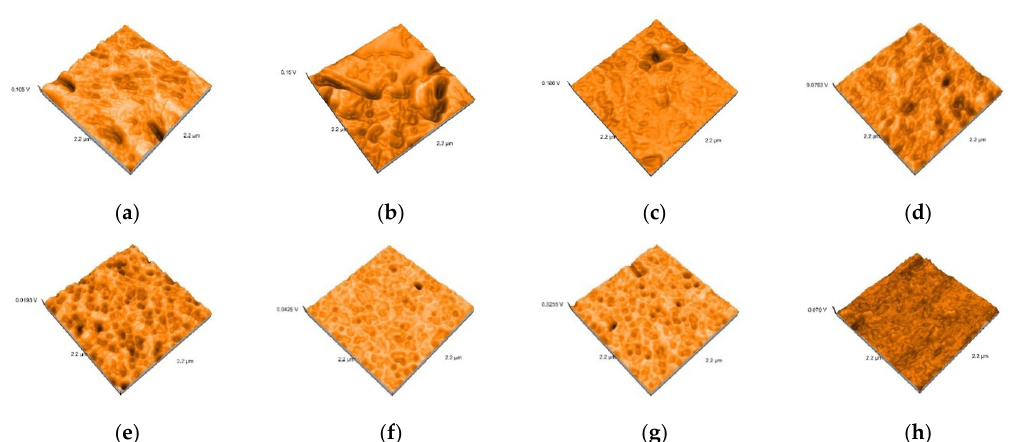
Figure 6. 3D images of Shofu HC specimens: ( a ) Shofu tribochemical silica airborne particle abrasion, ( b ) Shofu sandblasted, ( c ) Shofu etched, ( d ) Shofu polished ( e ) Shofu tribochemical silica airborne particle abrasion and glazed, ( f ) Shofu sandblasted and glazed, ( g ) Shofu etched and glazed ( h ) Shofu polished and glazed.